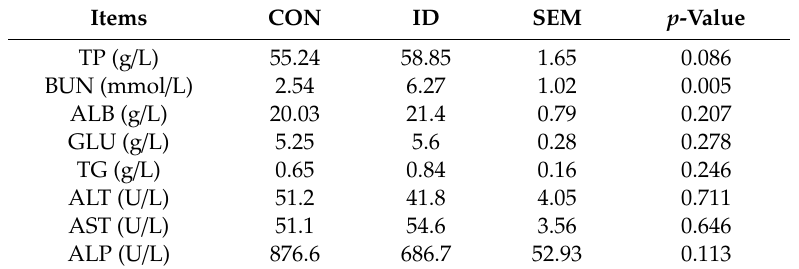
Table 3. Serum biochemical parameters of neonatal piglets with or without iron supplementation.